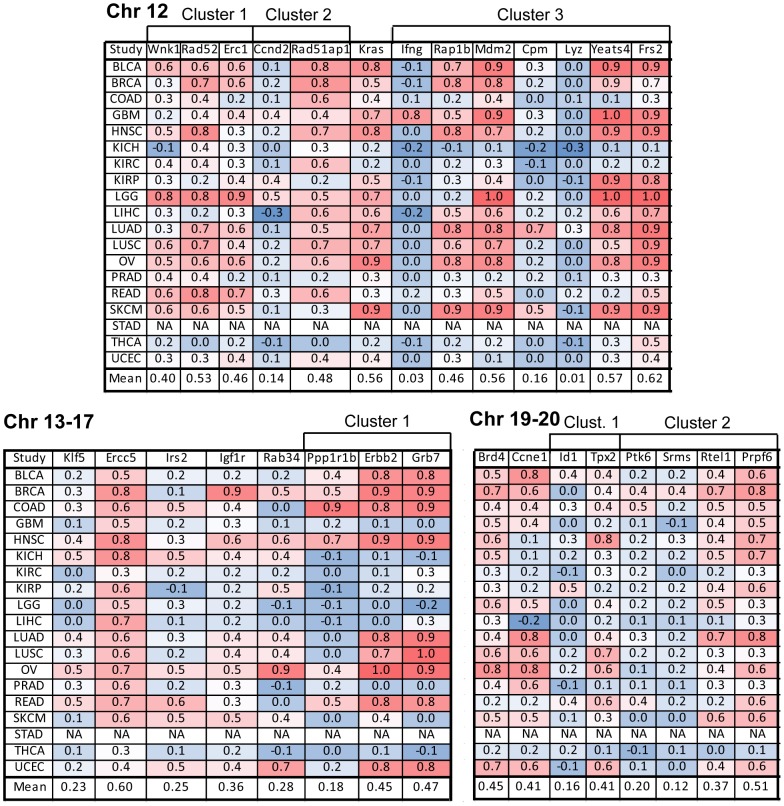
Gene copy number and mRNA expression correlation analysis to identify putative driver genes amplified on chromosomes 12–20.Pearson correlation coefficients were calculated by analyzing gene copy number and mRNA expression from individual patient-derived samples in TCGA datasets. Shown are the correlation coefficients for each TCGA cancer subtype and the mean correlation across all cancer types (red denotes high correlation, blue denotes low correlation). Abbreviations of TCGA datasets are listed in Figure 1.